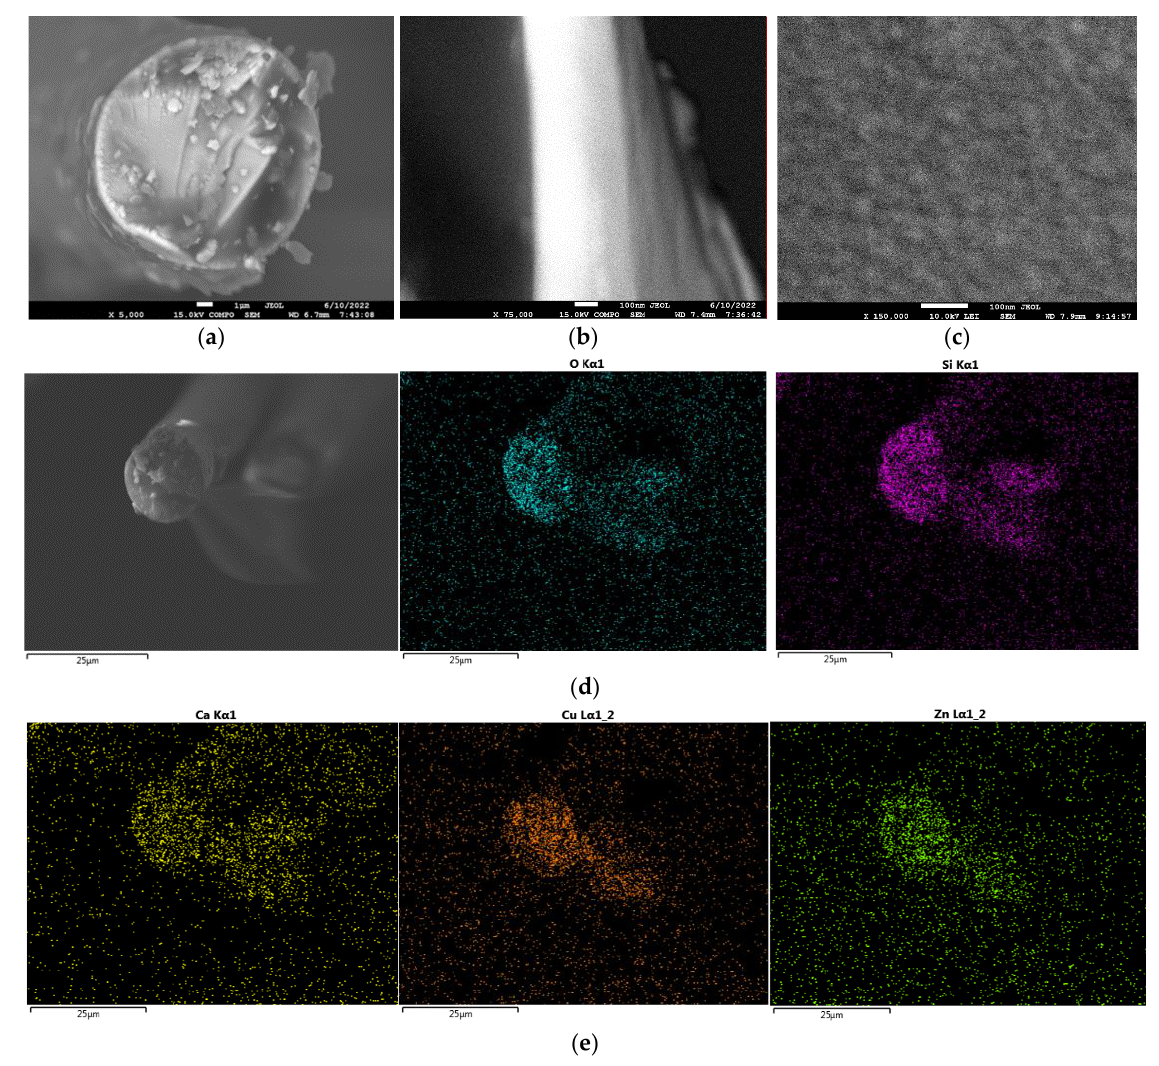
Figure 2. Microstructure of the surface of metallized glass fiber with brass film after two sputterings: ( a ) fiber projection; ( b ) brass film at medium magnification; ( c ) brass film surface at high magnifica- tion; ( d , e ) corresponding element distribution spectrum on brass film metalized fiber.